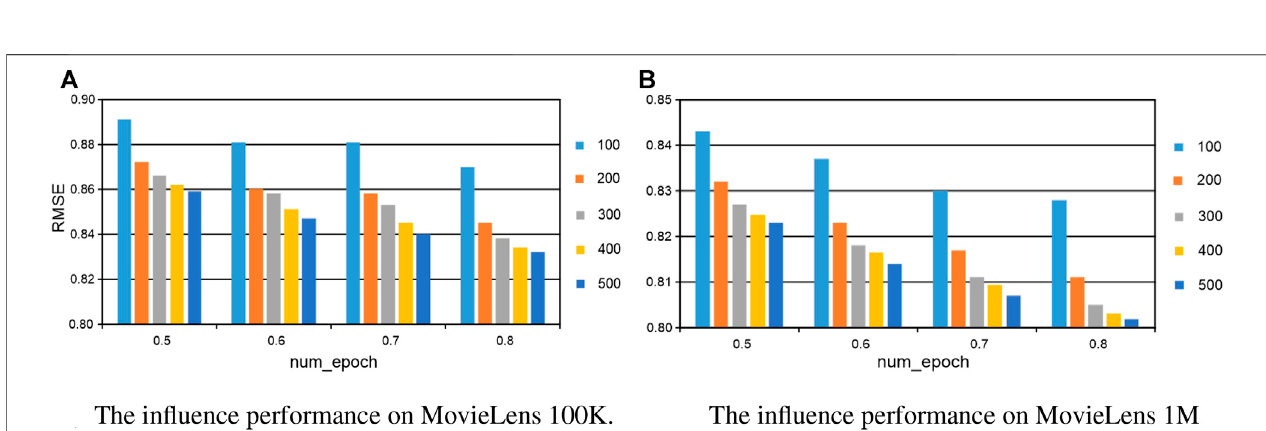
FIGURE 5 | The parameter in fl uence of the number of hidden layer neurons on our KGTA. (A) The in fl uence performance on MovieLens 100K. (B) The in fl uence performance on MovieLens 1M.